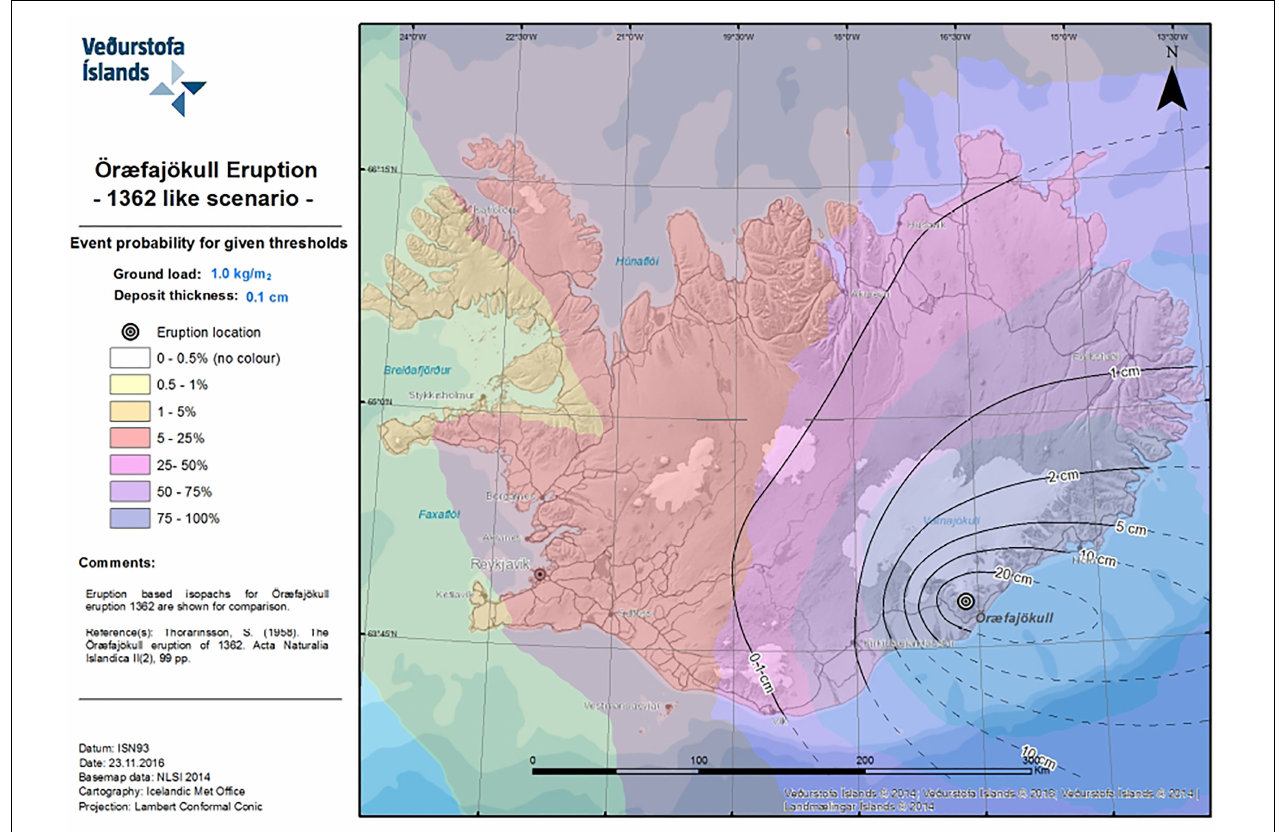
FIGURE 6 | Probabilistic hazard map for tephra loading higher than 1.0 kg/m 2 given an eruption at Öræfajökull as 1362 AD. The isopachs reconstructed by Thorarinsson (1958) are reported as a reference with black lines.